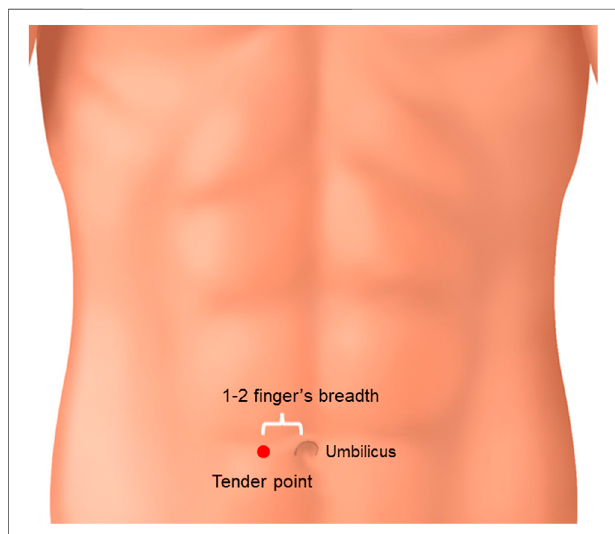
FIGURE 3 | Tender point of jidabokuippo. When abdominal tenderness at the right side of the paraumbilical site was observed, JDI might have been